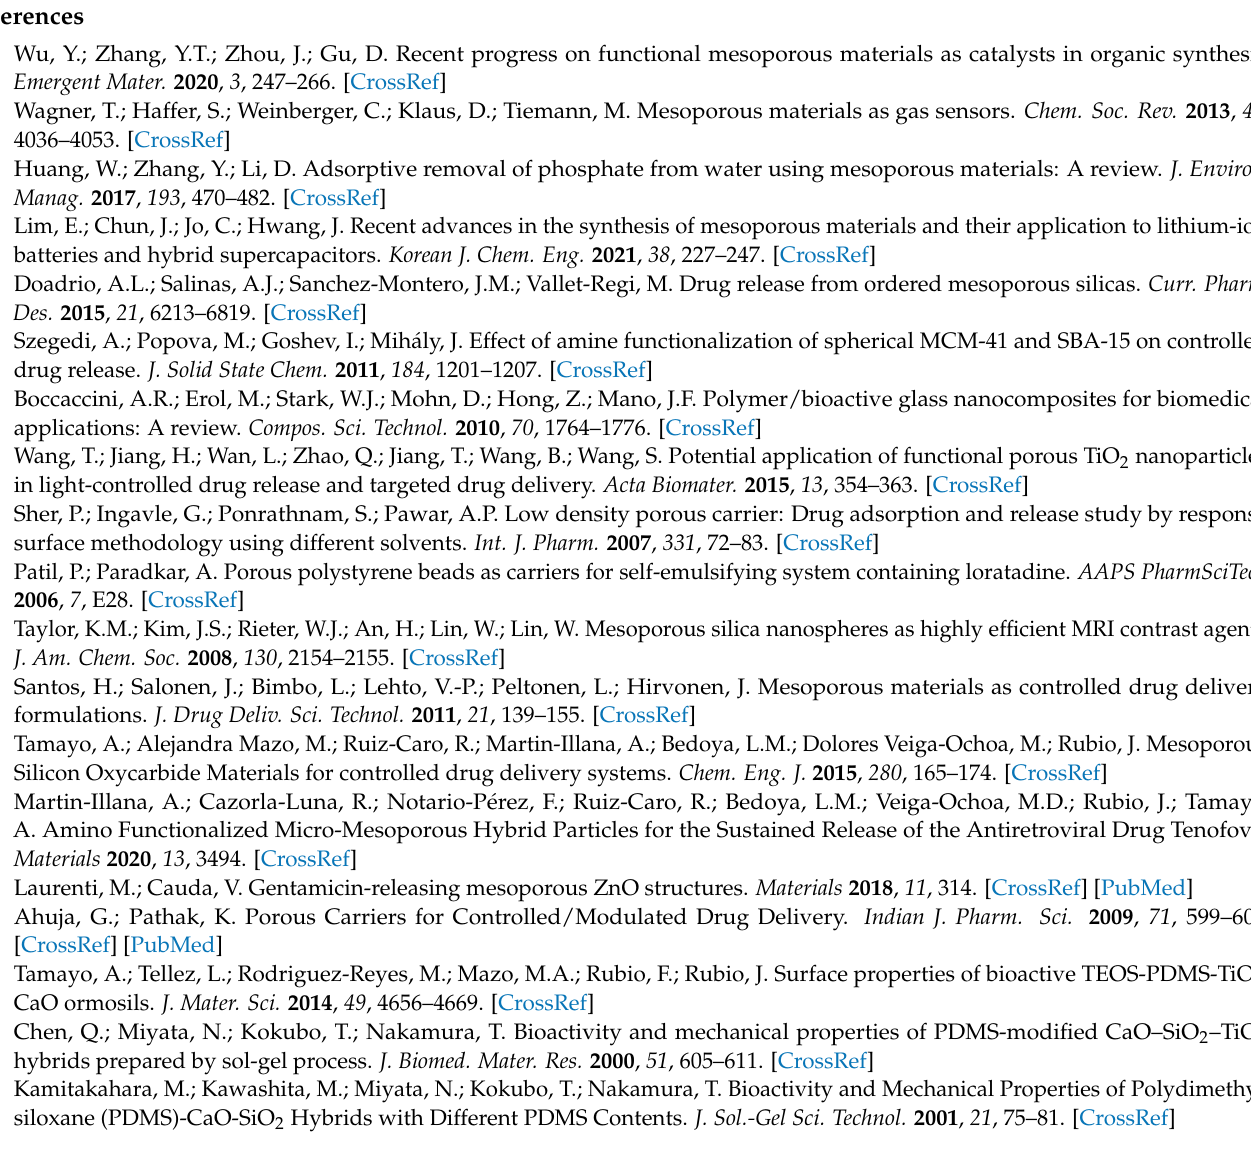
Table S5: Table summarizing the kinetical data obtained through the application of the Korsmeyer- Peppas model, Table S6: Table summarizing the kinetical data obtained through the application of the Weibull